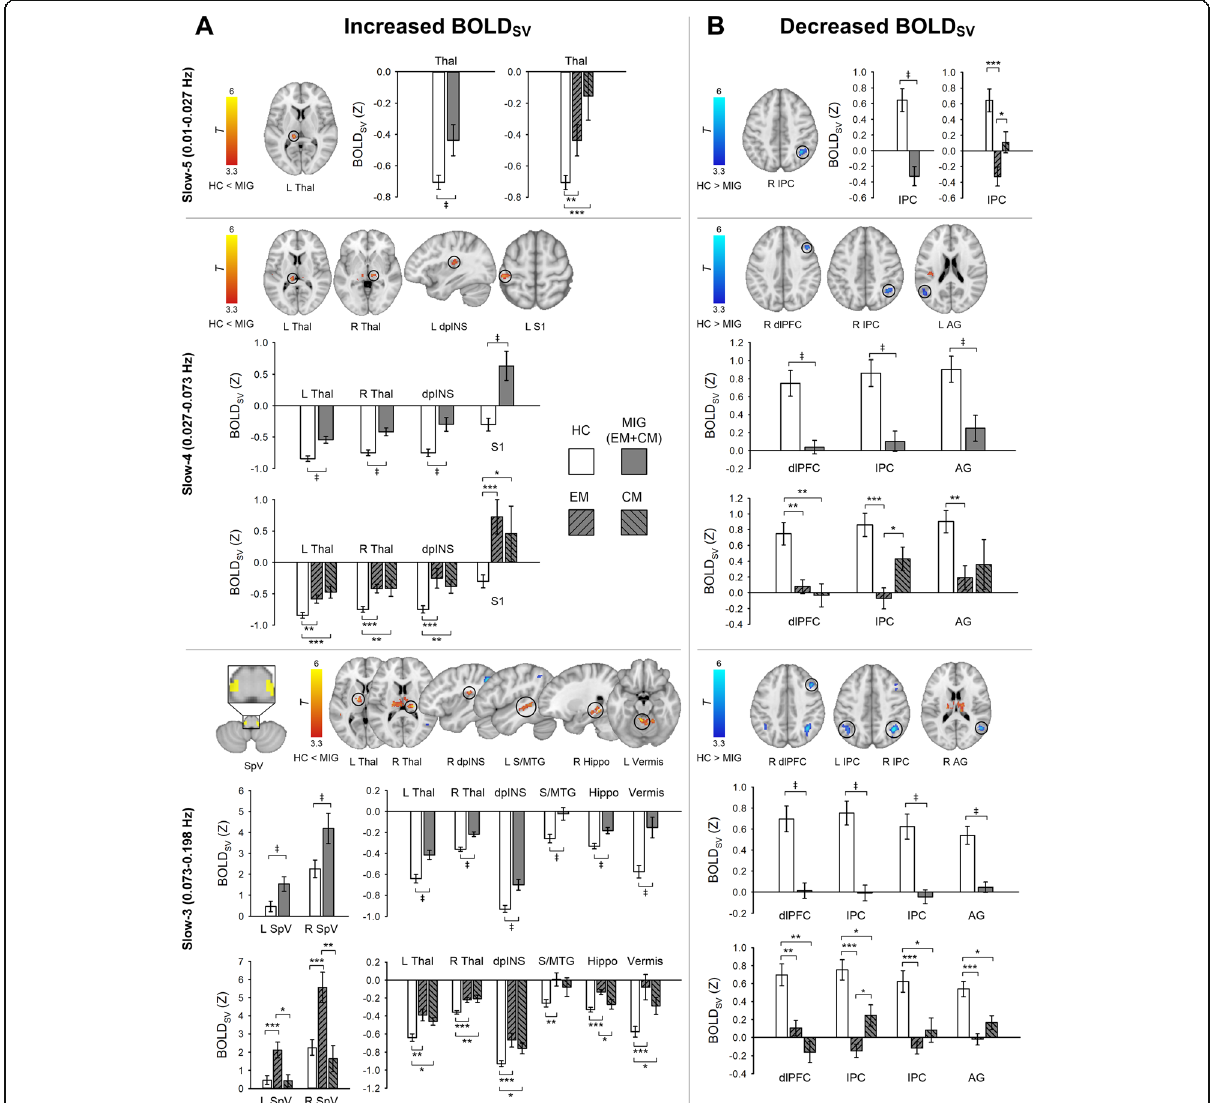
Fig. 2 Group differences of BOLD SV in the frequency band slow-5 (0.01 – 0.027Hz), slow-4 (0.027 – 0.073Hz), and slow-3 (0.073 – 0.198 Hz). a Brain regions displaying increased BOLD SV in MIG patients compared with HCs. Separate voxel-wise permutation tests in each frequency band were performed for the SpV mask. Significant clusters (yellow) were identified using a threshold-free cluster enhancement ( p < 0.05, FWE-corrected) (bottom). b Brain regions displaying decreased BOLD SV in MIG patients compared with HCs. All statistical images are displayed with significant clusters (voxel-level threshold p < 0.001 and cluster-level extent threshold p < 0.05, FWE-corrected). Bar graphs were expressed as mean ± standard error of the mean. Mean BOLD SV (Z) was extracted from a 3-mm sphere around the peak voxel of each significant cluster. Gray squares/bars represent MIG patients (n = 20), white squares/bars represent HC subjects (n = 26). MIG patients were divided into EM (n = 13) or CM (n = 7) groups for further subgroup comparison. ‡ p < 0.05 (FWE-corrected). * p < 0.05, ** p < 0.01, and *** p < 0.001 for unpaired t -test. S1, primary somatosensory cortex; AG, angular gyrus; MIG, migraine; HC, healthy control; EM, episodic migraine; CM, chronic